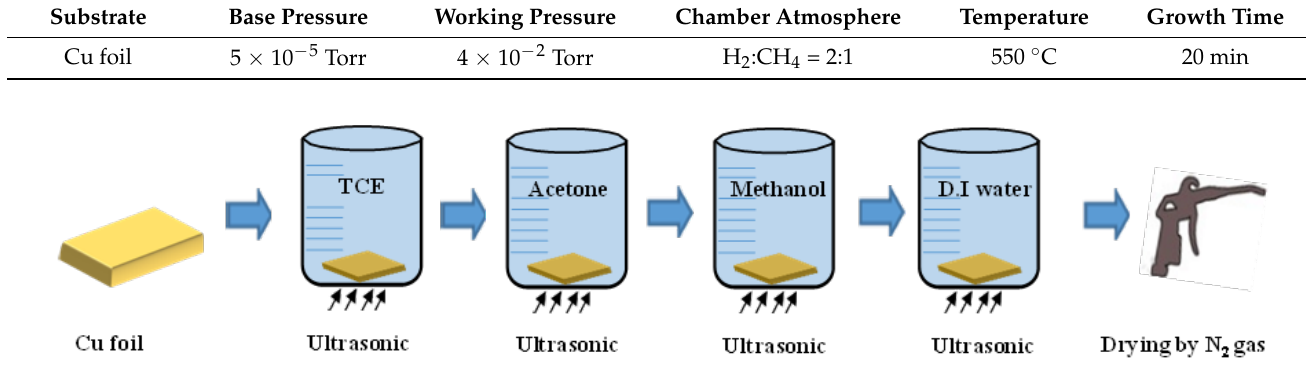
Figure 2. Schematic diagram of the Cu foil cleaning.